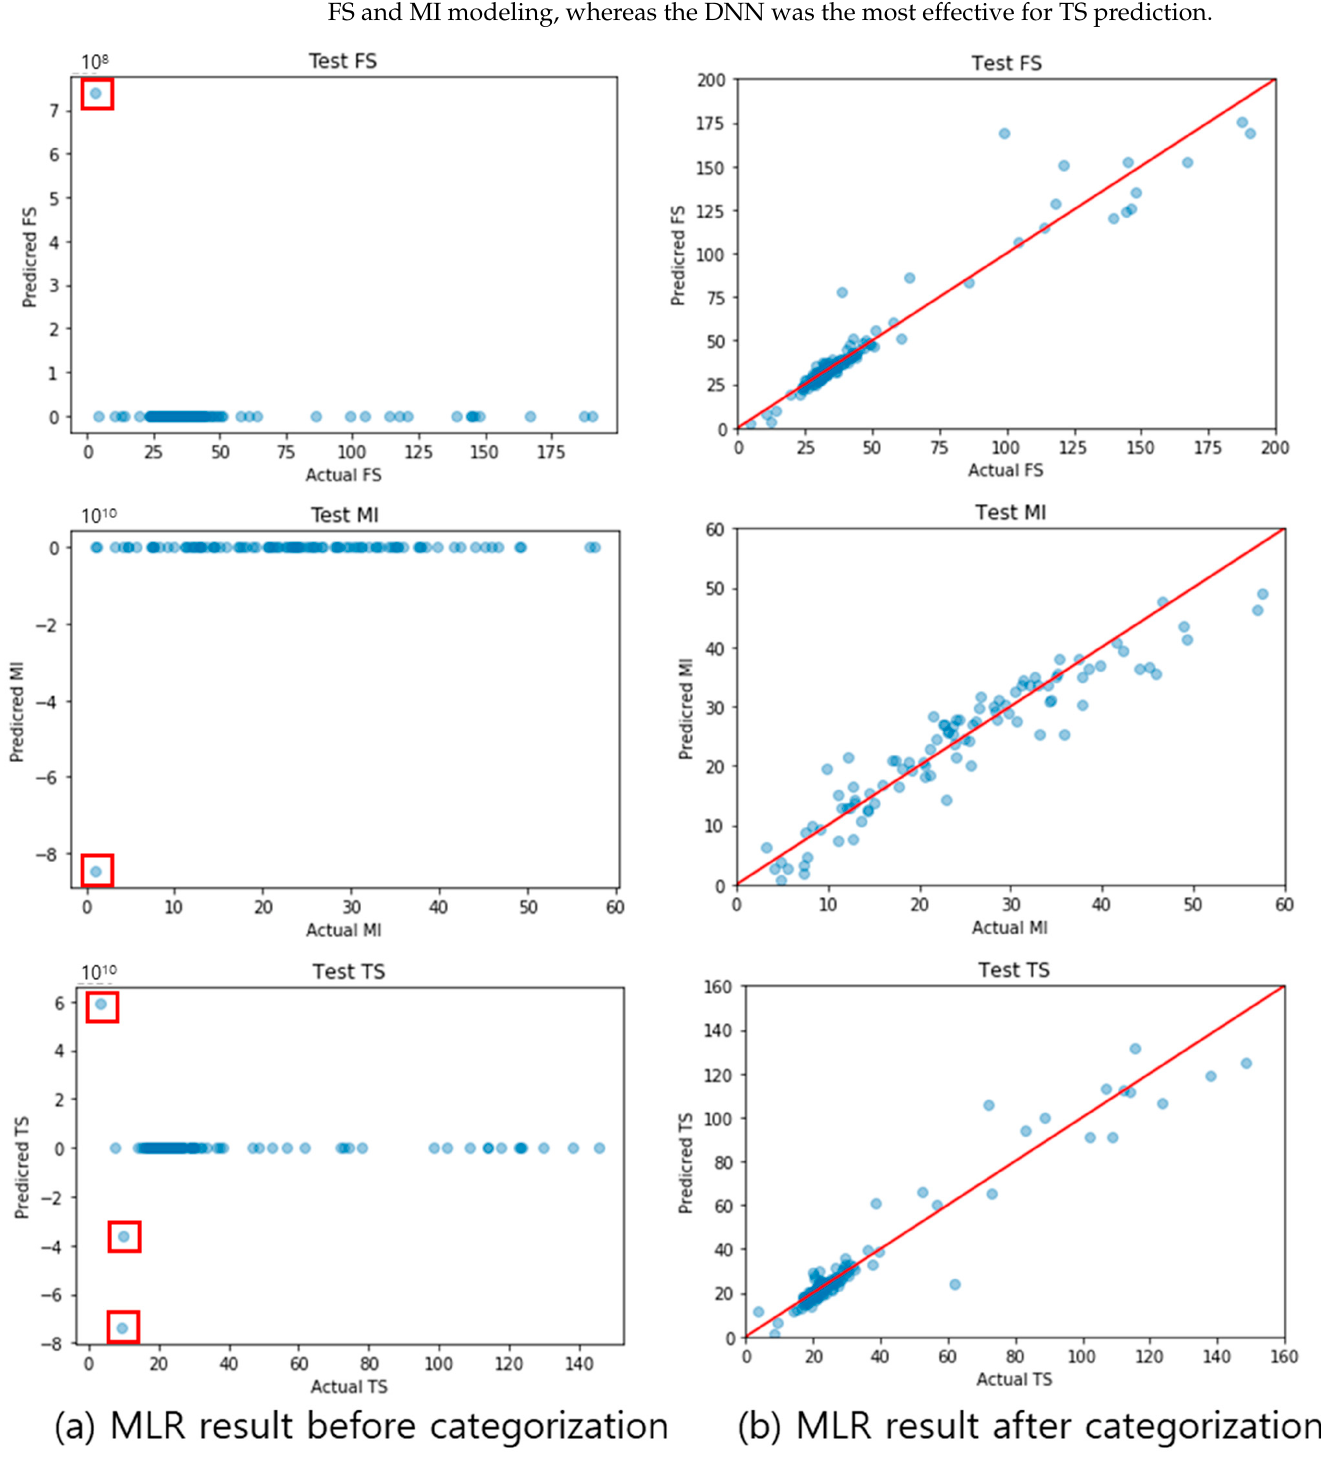
Figure 13. Parity plots of MLR results using pre-categorization data ( a ) and post-categorization data ( b ); the red square indicates a large error point between the actual and predicted value, and the red line is y = x (where x is the actual value and y is the predicted value).